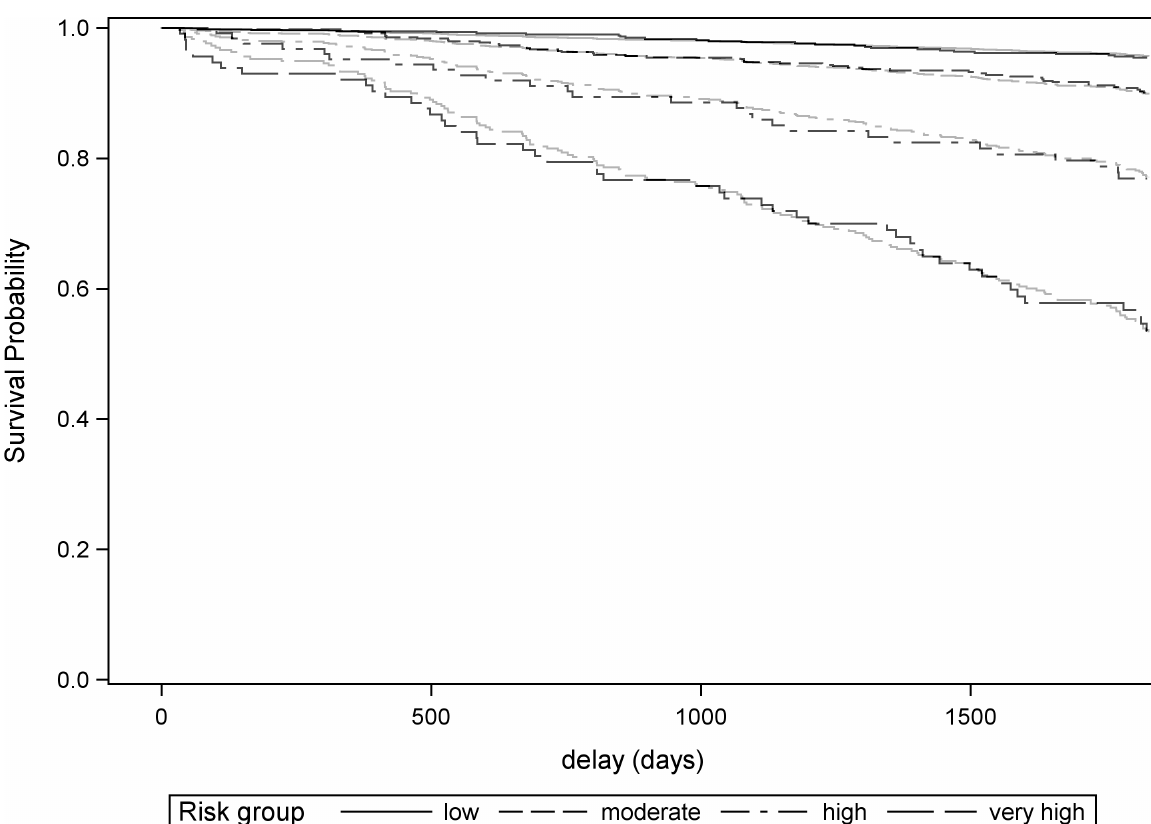
PLOS ONE | https://doi.org/10.1371/journal.pone.0195725 April 19,